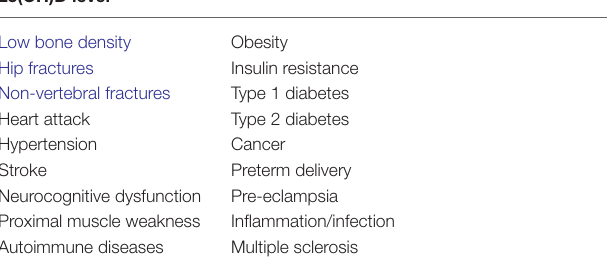
TABLE 1 | Vitamin D and human health. network is depicted schematically in the right panel of Figure 1 . Stimulation of the Toll-like receptor signaling pathway by pathogen-associated molecular pattern (PAMP) molecules induces expression of CYP27B1 and VDR as well as of monokines (e.g., IL-15 and IL-1 β ). In an autocrine mode, these two monokines act to amplify expression of the CYP27B1 and 1,25(OH) 2 D-VDR-directed generation of antimicrobial peptides (34). In a paracrine fashion IL-1ß mobilizes and activates cells of the adaptive immune response (35–37).